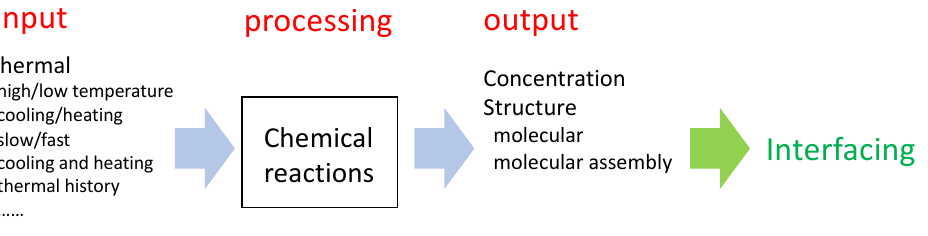
Figure 2. Thermal input/concentration output systems processed by chemical reactions and their interfacing.